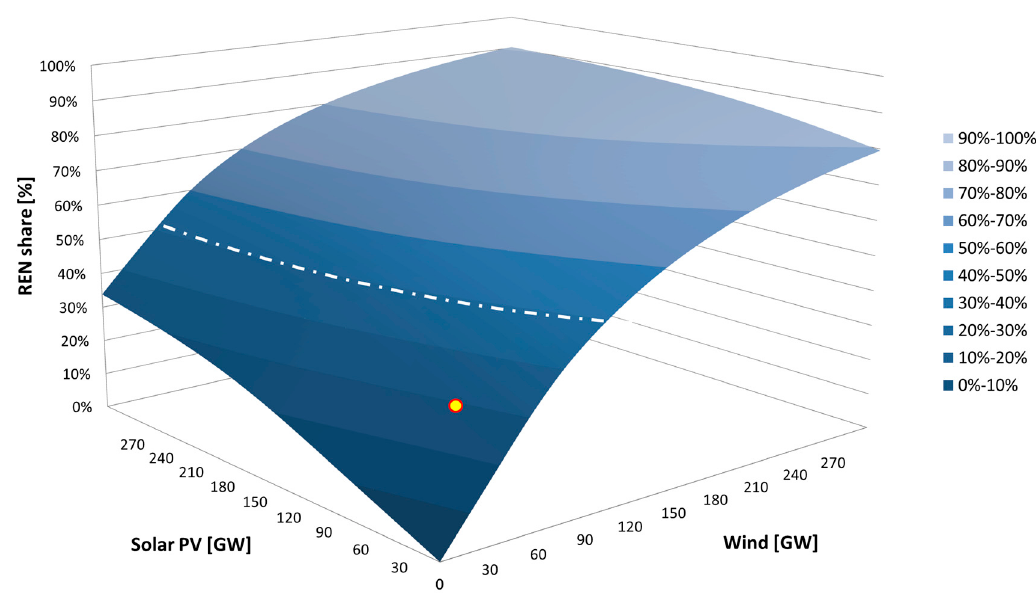
Figure 6. REN share surface plot for Case A, including the 2017 capacities from wind and solar PV (point marking), and the 50% REN share marking for various combinations resulting in a 50% REN share (mixed dotted-dashed line).